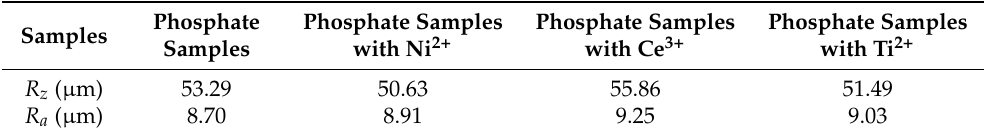
Table 6. The values of surface roughness for phosphate sample and phosphate samples with Ni 2+ , Ce 3+ , and Ti 2+